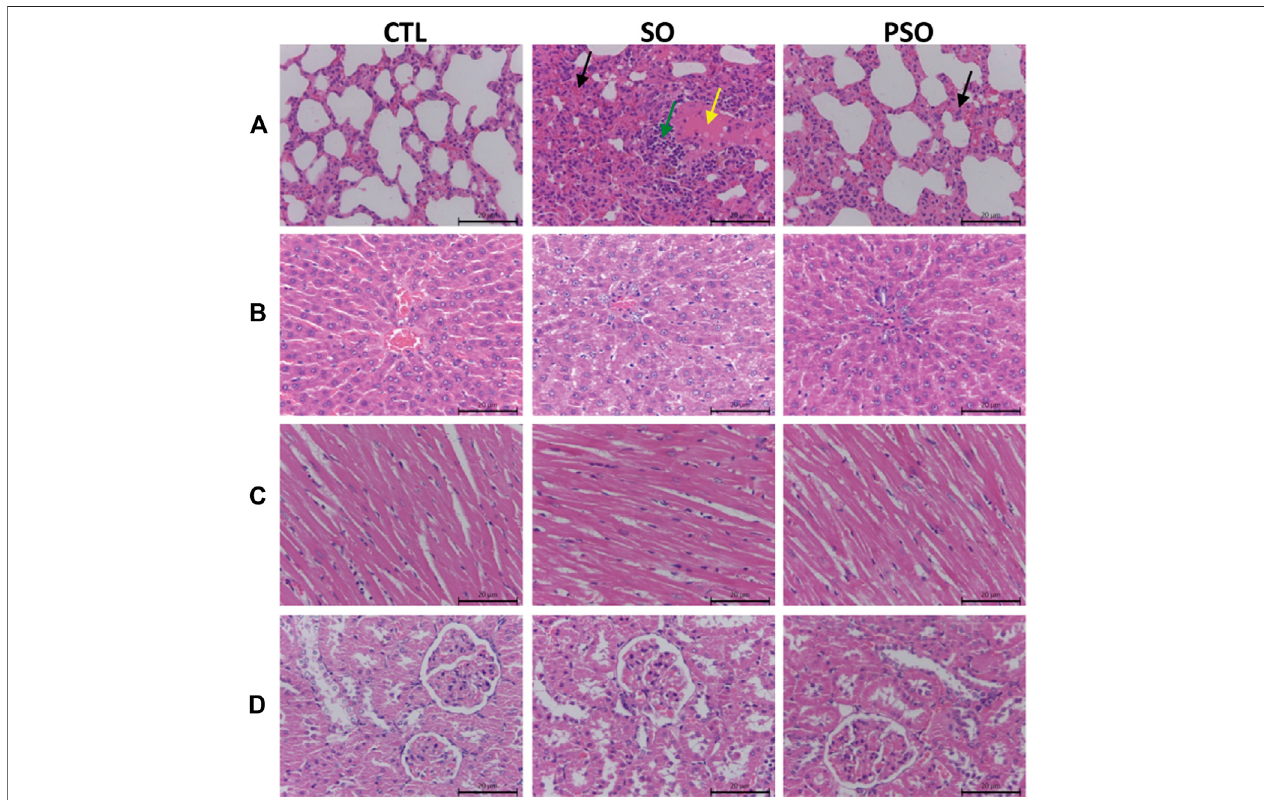
FIGURE 2 | Histopathological examinations of the lung, liver, heart, and kidney tissues in vehicle-, raw SO- and PSO-treated rats. H&E staining, 200 × . (A) Lung tissue of each group: yellow arrow represents serous exudation in the alveolar cavities, green arrow represents in fl ammatory cell in fi ltration, black arrow represents the thickened alveolar septum, and the capillaries are dilated and congested; (B) liver tissue of each group; (C) heart tissue of each group; and (D) kidney tissue of each group.